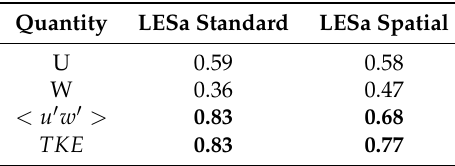
Table 5. Hit rate metric q without and with spatial